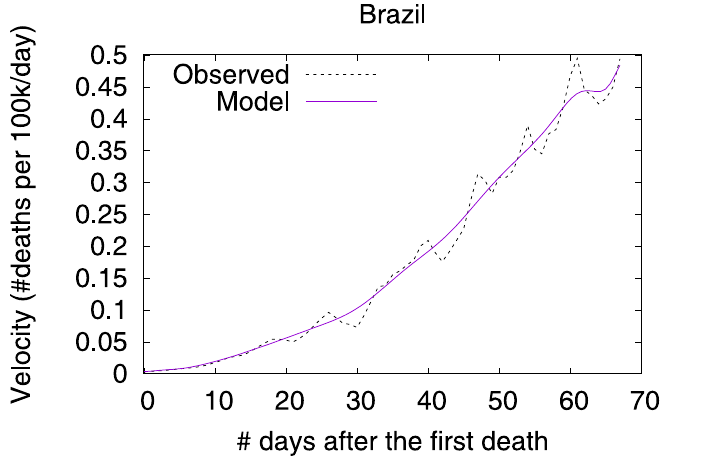
Fig 26. (Color online) projections for velocity in